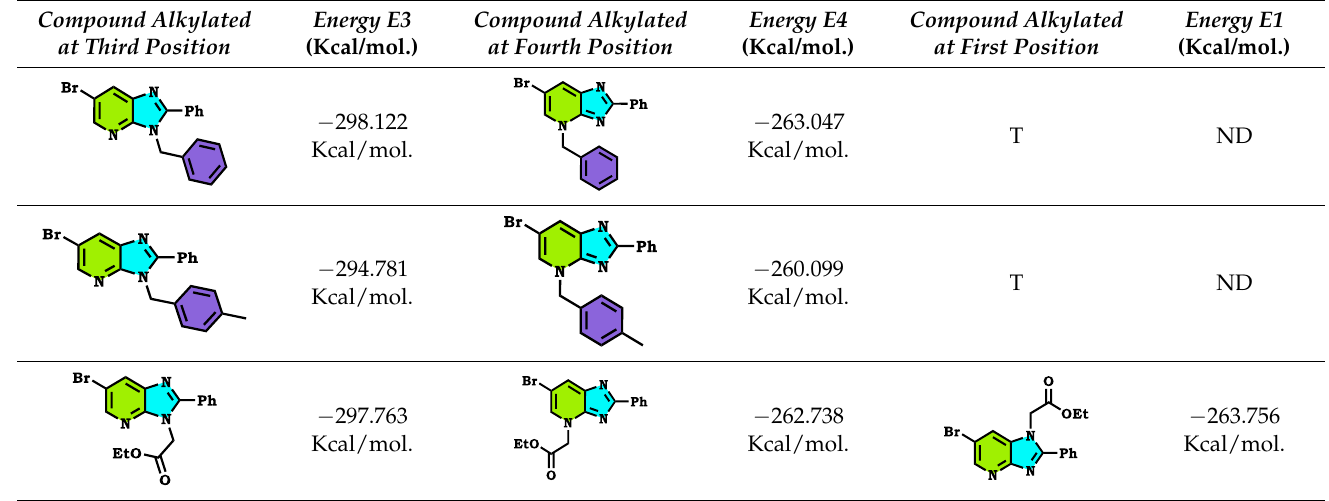
Table 1. Total energies of all synthesis imidazo[4,5-b]pyridine derivatives ( 2 – 8 ).